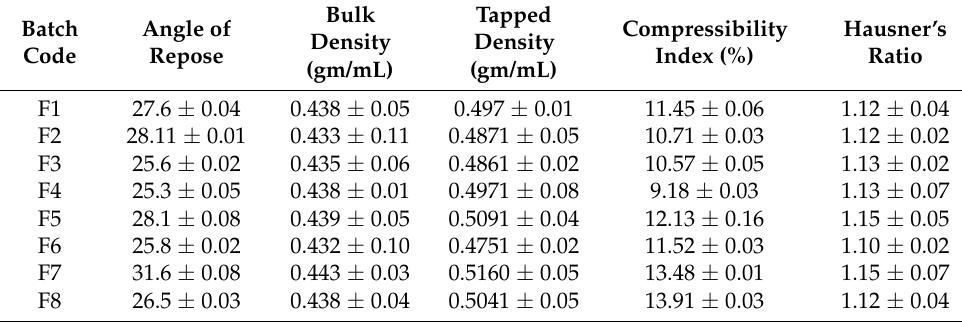
Table 3. Flow properties of metronidazole loaded effervescent floating